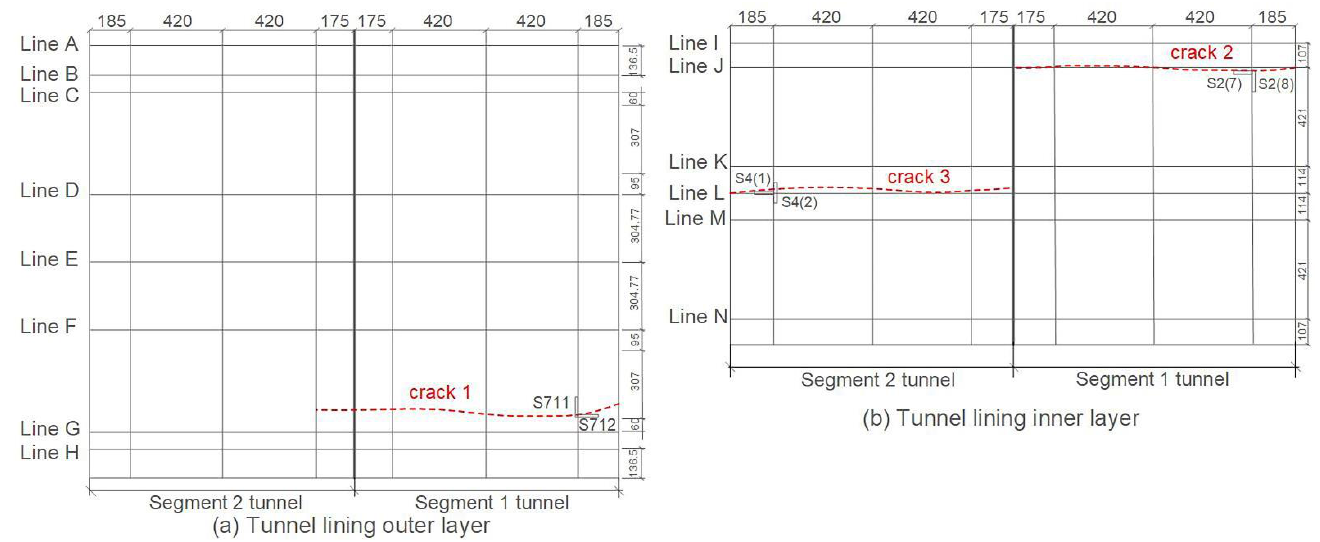
Figure 4. Schematic diagram of apparent cracks after test. Subpicture ( a ), Segment 1 tunnel: crack 1 appeared on the arch foot of the left sidewall of lining outer layer (Line G). Subpicture ( b ), Segment 1 tunnel: crack 2 appeared on the arch foot of the right sidewall of lining inner layer (Line J), and Segment 2 tunnel: crack 3 appeared on the vault of lining inner layer (Line L). The data units in the figure are mm.